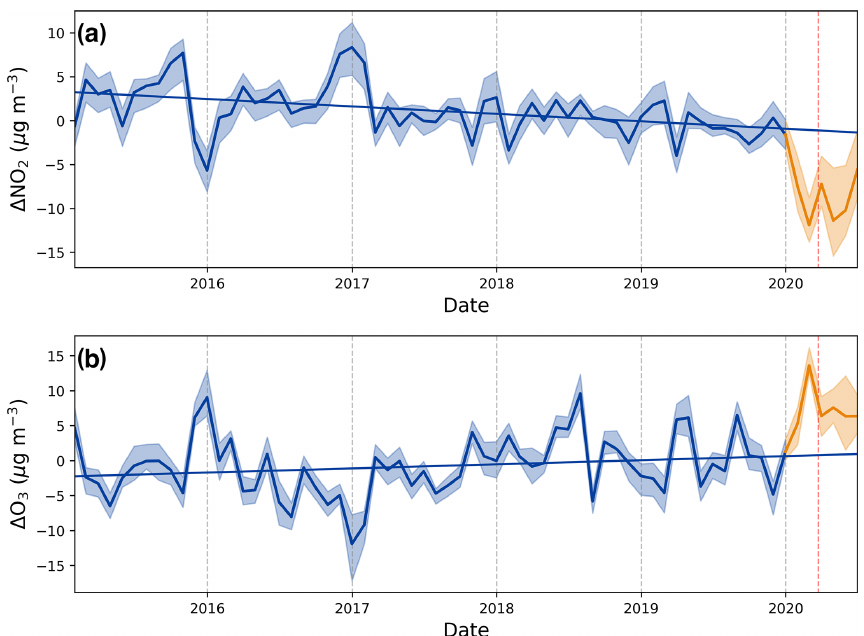
Figure 2. Mean relative change of deseasonalized UK values of (a) NO 2 and (b) O 3 for all urban background and traffic sites from 2015 to 2020, with the mean 2015–2019 trend superimposed. Data from 2020 are shown in orange, with the red dashed line denoting the start of the lockdown on 23 March 2020. The 25–75% range is shown by the shaded